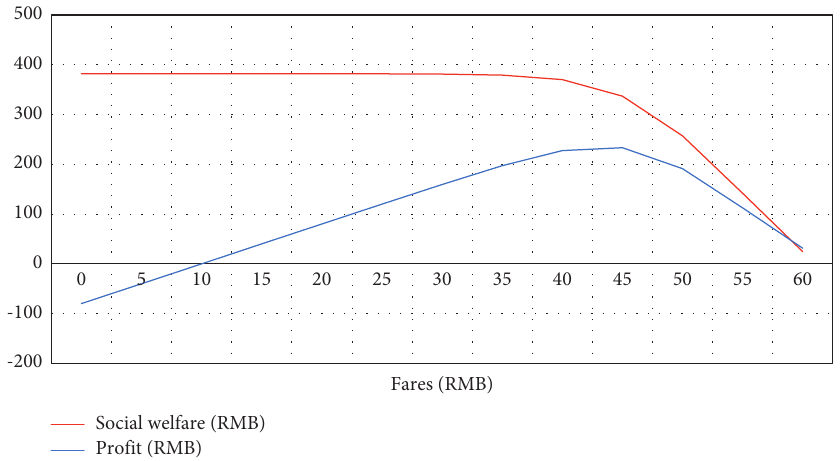
Figure 7: The relationship between fares, profit, and social welfare in Case 1.